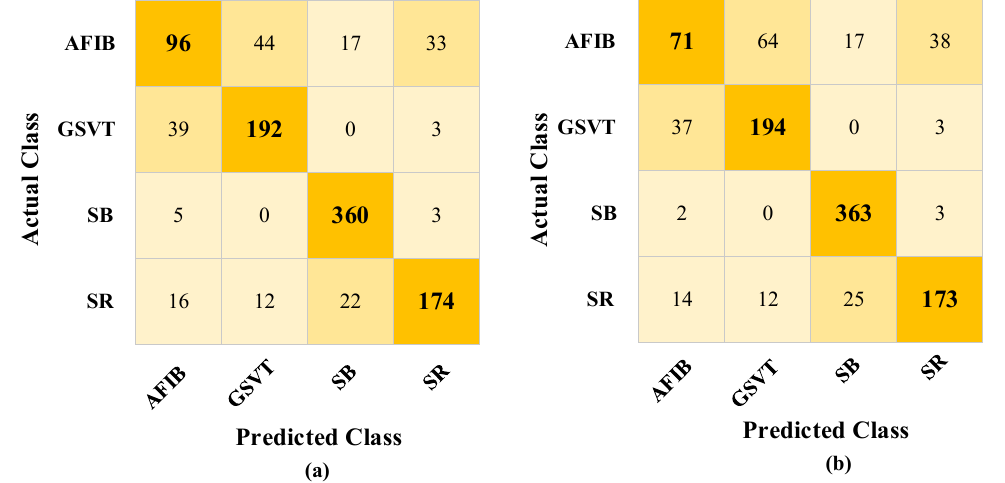
Figure 5. Confusion matrices obtained on test data for QSVM and SVM: ( a ) confusion matrix for QSVM, ( b ) confusion matrix for SVM.